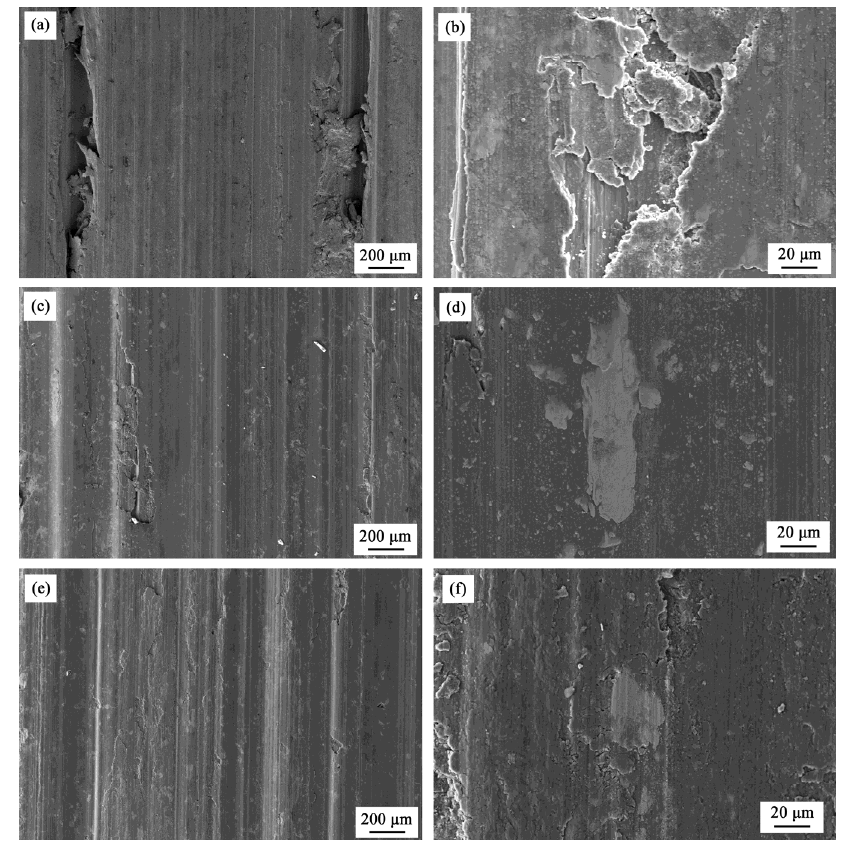
Figure 8. SEM micrographs of worn tracks of samples: ( a and b ) S000; ( c and d ) S300; ( e and f )